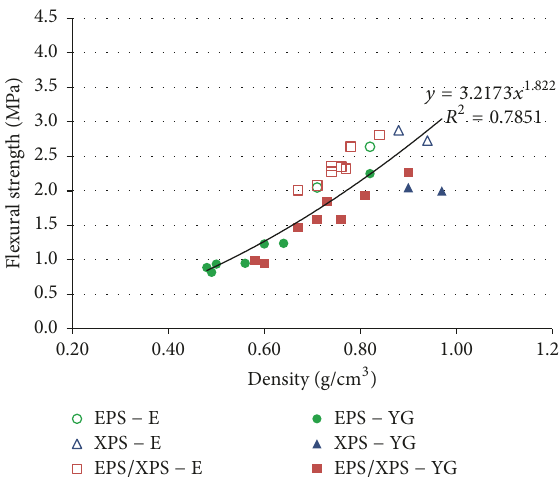
Figure 2: Relationship between flexural strength and the density of the